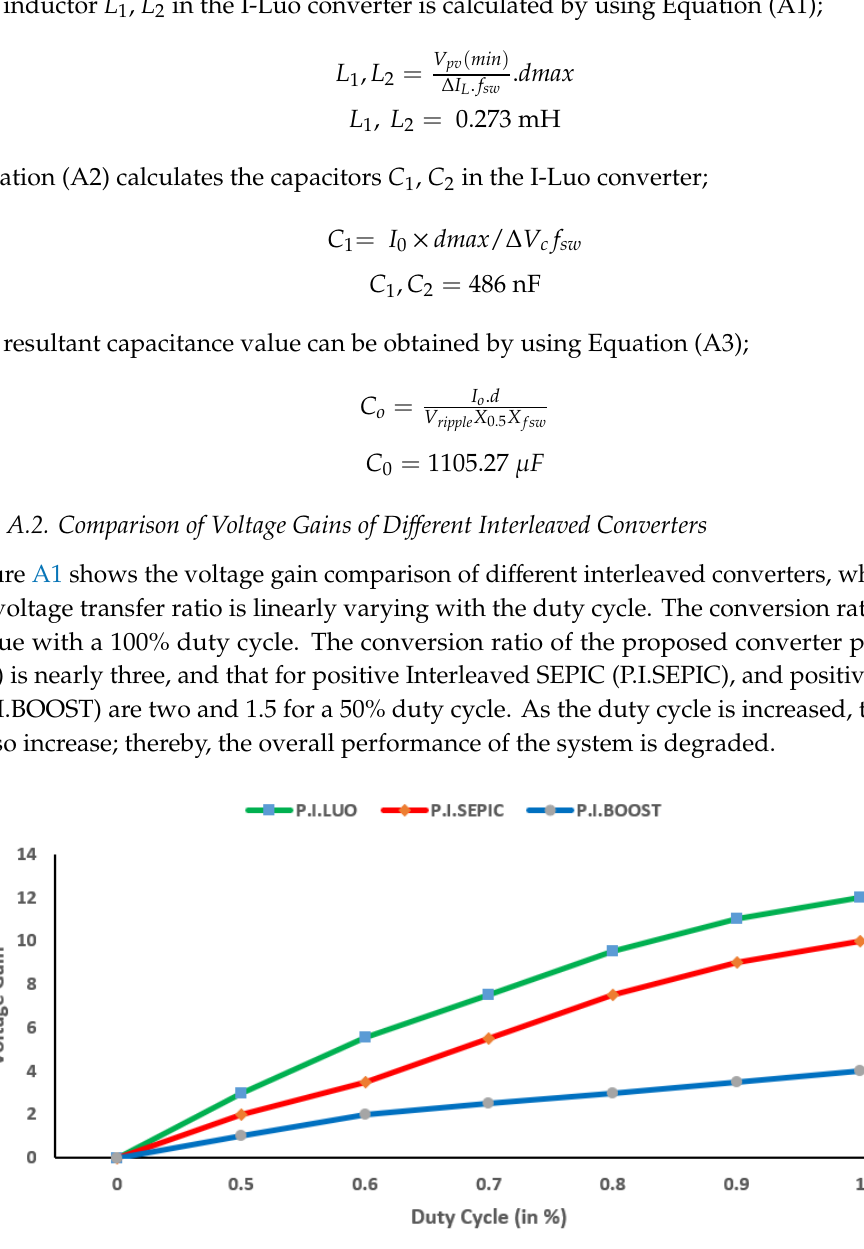
Figure A1. Comparison of voltage gains of different interleaved converters.